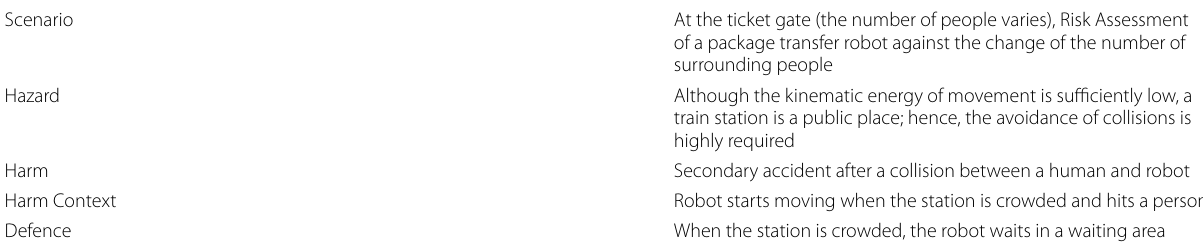
Table 2 Risk assessment table